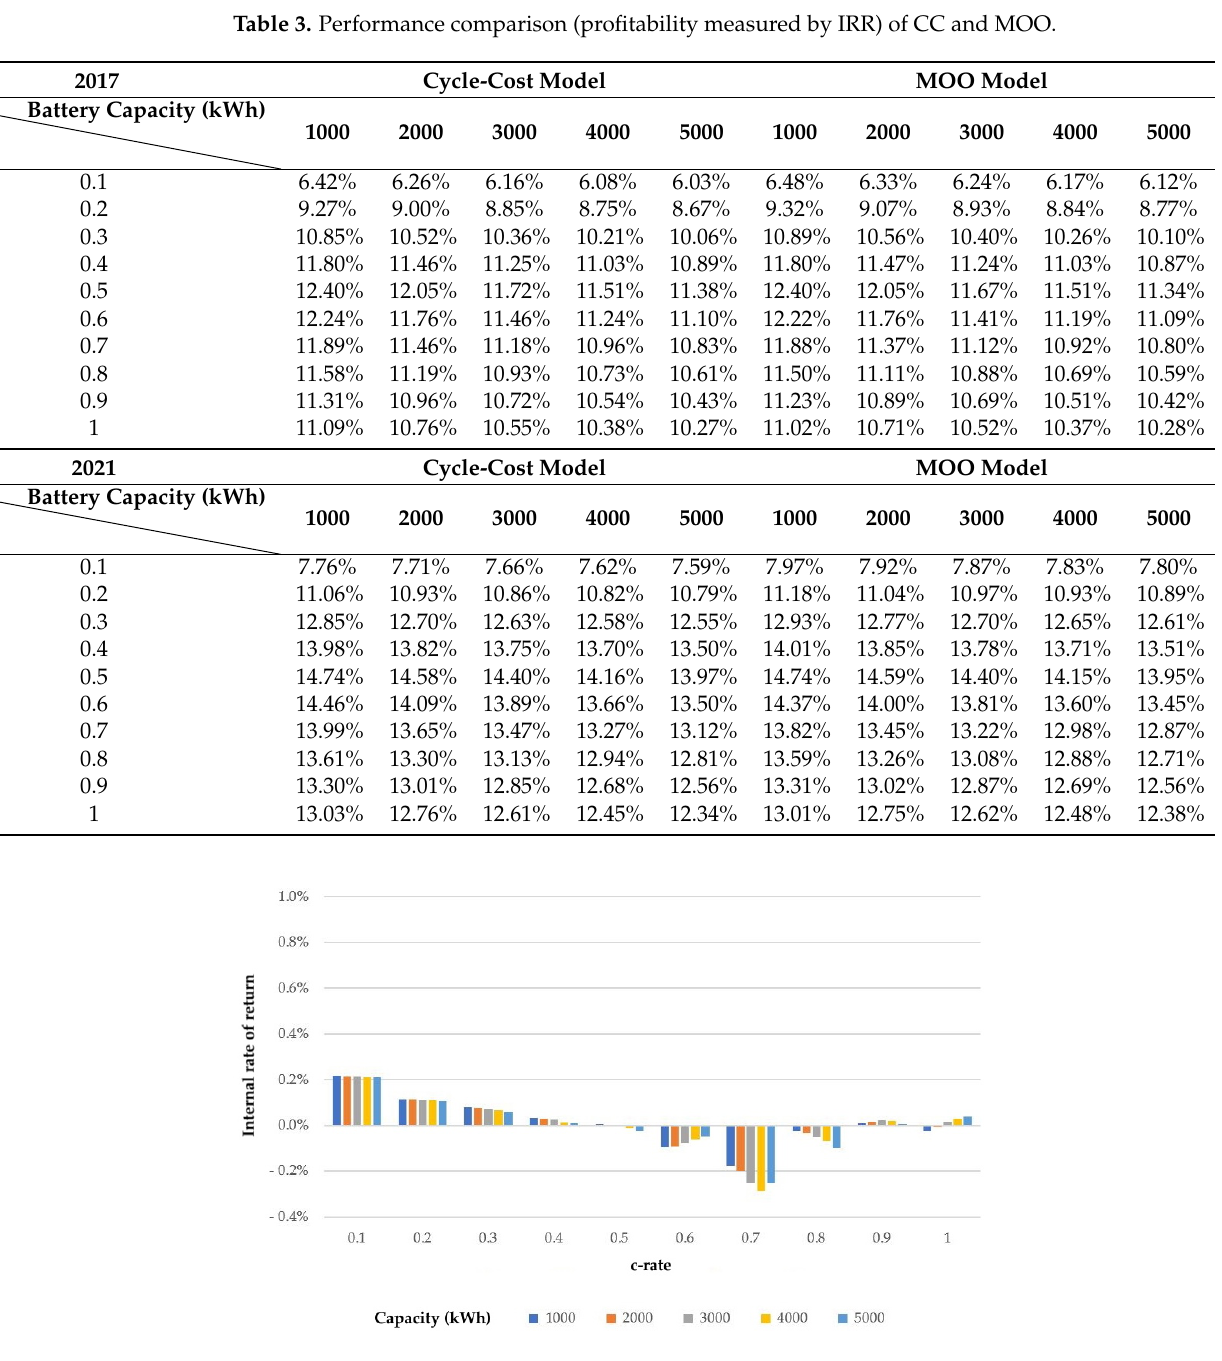
Figure 2. Difference in profitability between MOO and CC approaches (IRR of CC is subtracted from IRR of MOO) in 2021 and battery capacity price of 400 €